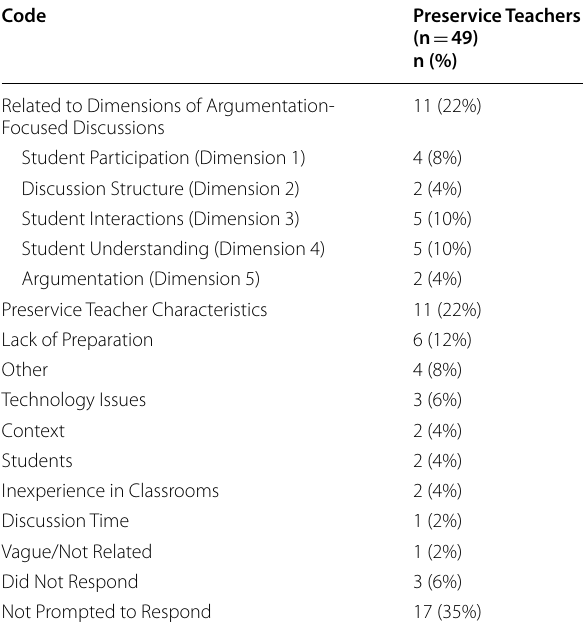
Table 5 Results for Preservice Teachers’ Perceptions about Discussion